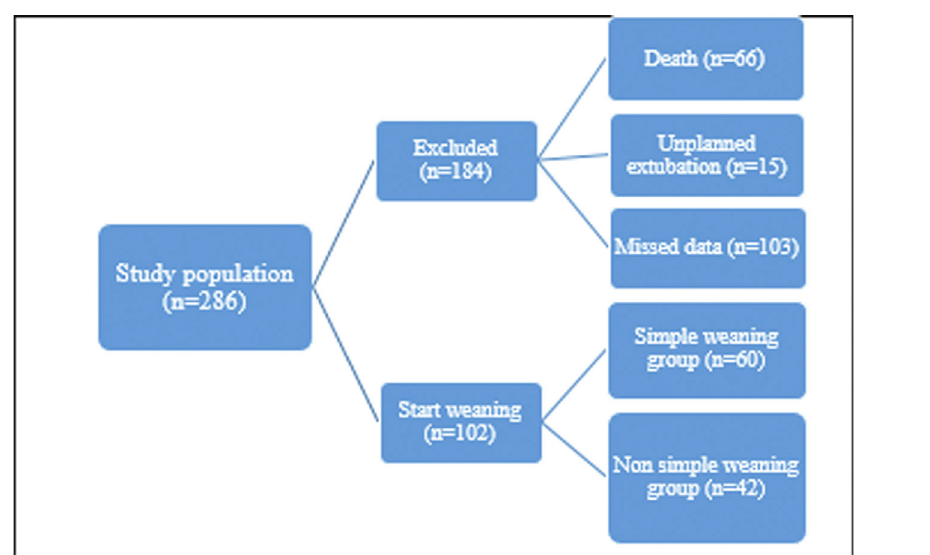
Scheme of the result analysis. The flow chart shows that the study includes 183patients; however, 81 patients were excluded as 66 patients died before the start of weaning and 15 patients had unplanned extubation. Therefore, the included 102 patients were classified into simple weaning group (60 patients) and nonsimple weaning group (42